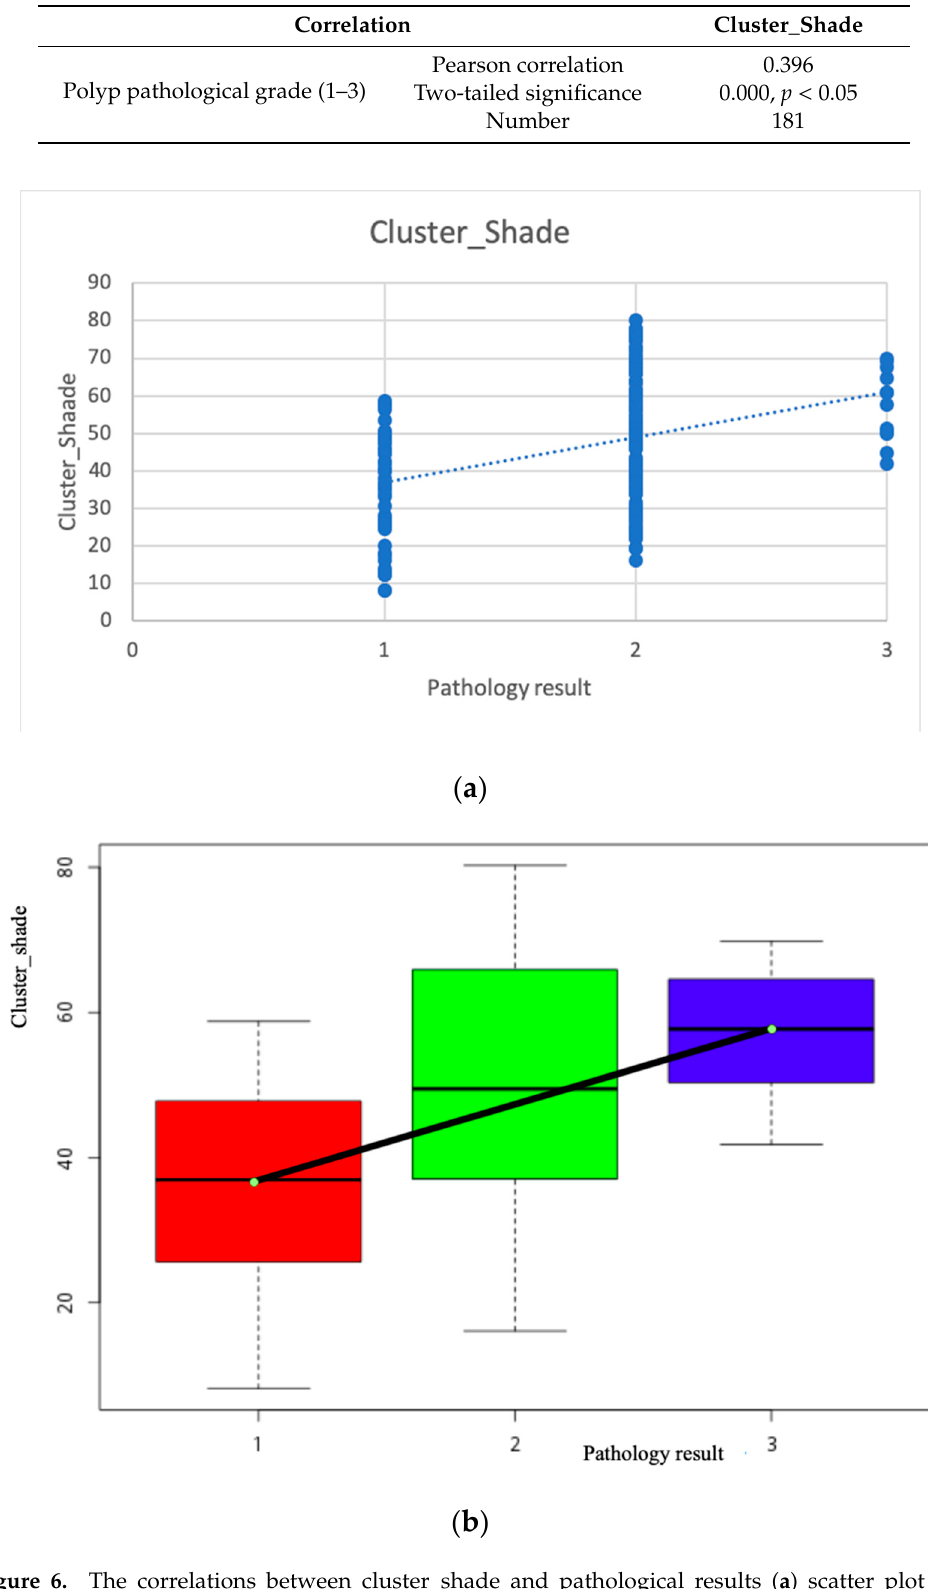
Figure 6. The correlations between cluster_shade and pathological results ( a ) scatter plot and ( b ) box-and-whisker plot. Pathology result 1 is hyperplastic polyps. Pathology result 2 is adenoma. Pathology result 3 is colon adenocarcinoma.